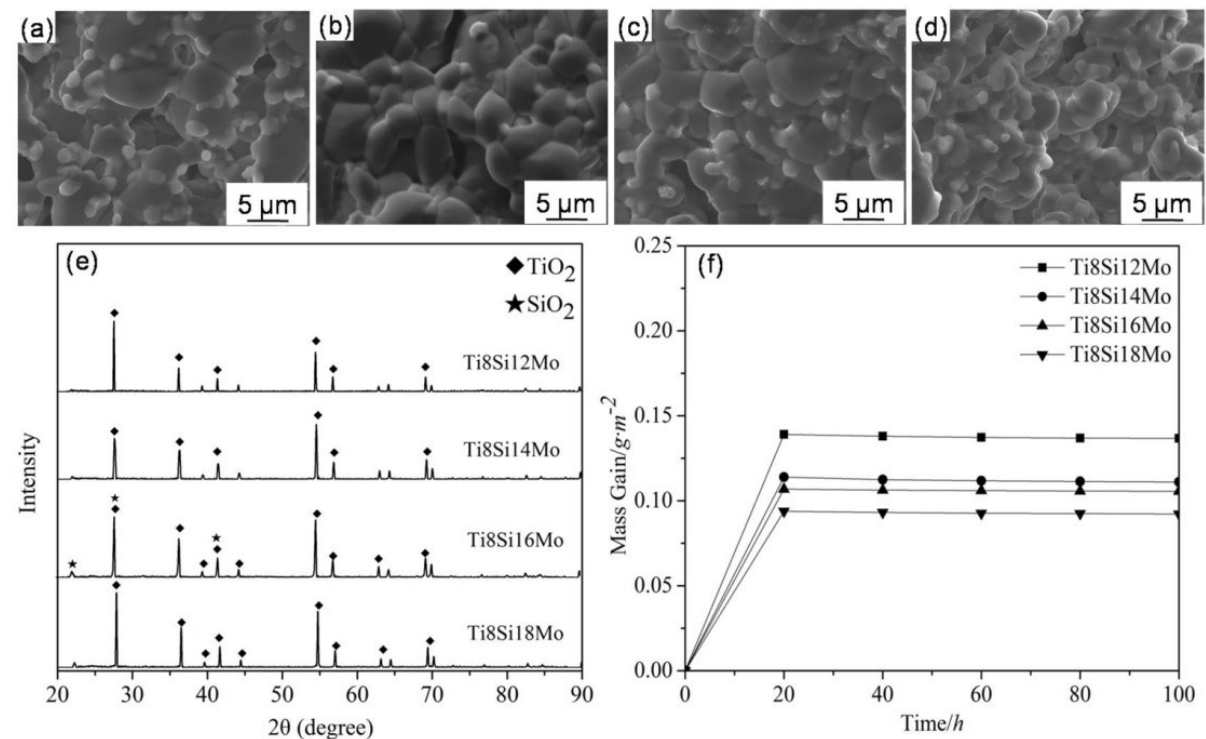
Figure 4: SEM morphologies, XRD patterns and mass gain curves of samples with different Mo contents oxidized at 1473 K for 100 h: (a) 12 wt.%, (b) 14 wt.%, (c) 16 wt.%, (d) 18